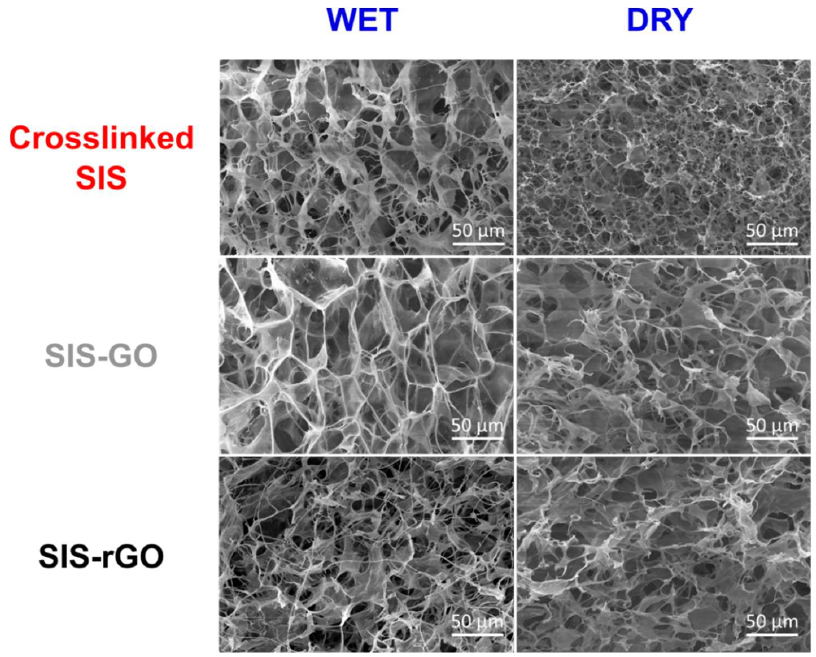
Figure 4. SEM images of hydrated and completely dry scaffolds. Pores appear homogenously distributed and well interconnected.